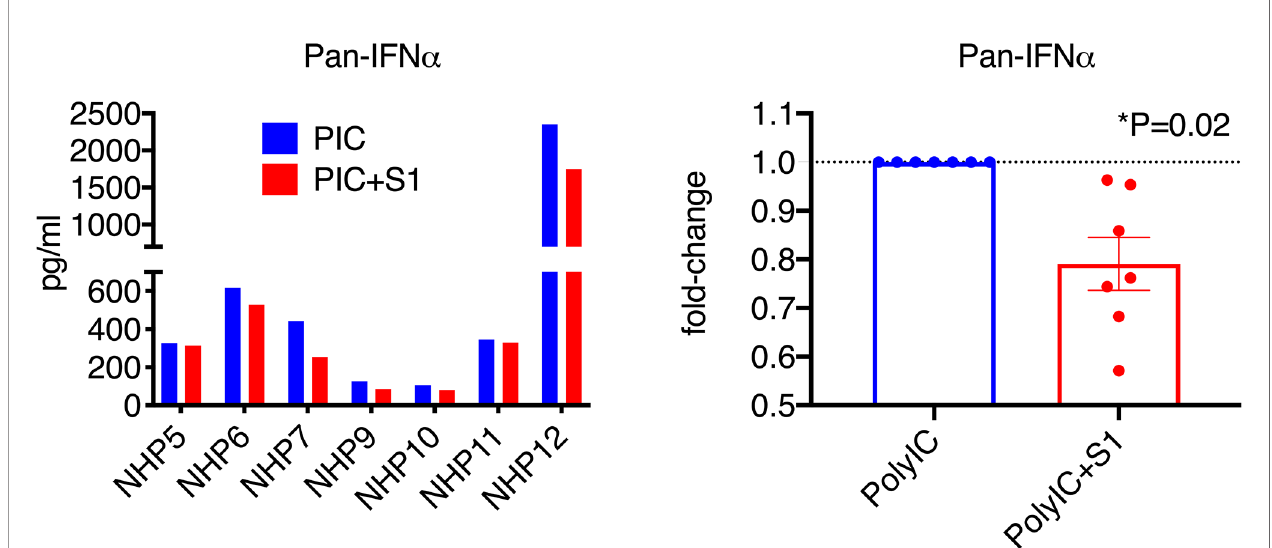
FIGURE 3 | SARS-CoV-2 spike protein reduced poly I:C-induced interferon a expression in lung bronchoalveolar lavage from naïve macaques. Primary lung bronchoalveolar lavage fl uids from 7 naïve rhesus macaques were cultured with 1 mg of poly I:C with or without 1 µg/ml of spike protein S1 for 20 hrs. Supernatants were collected, and a Pan interferon a ELISA was used to measure the total expression level of interferon a . The right panel shows the data with poly I:C normalized to 1 for each animal to calculate the fold changes in the presence of spike protein